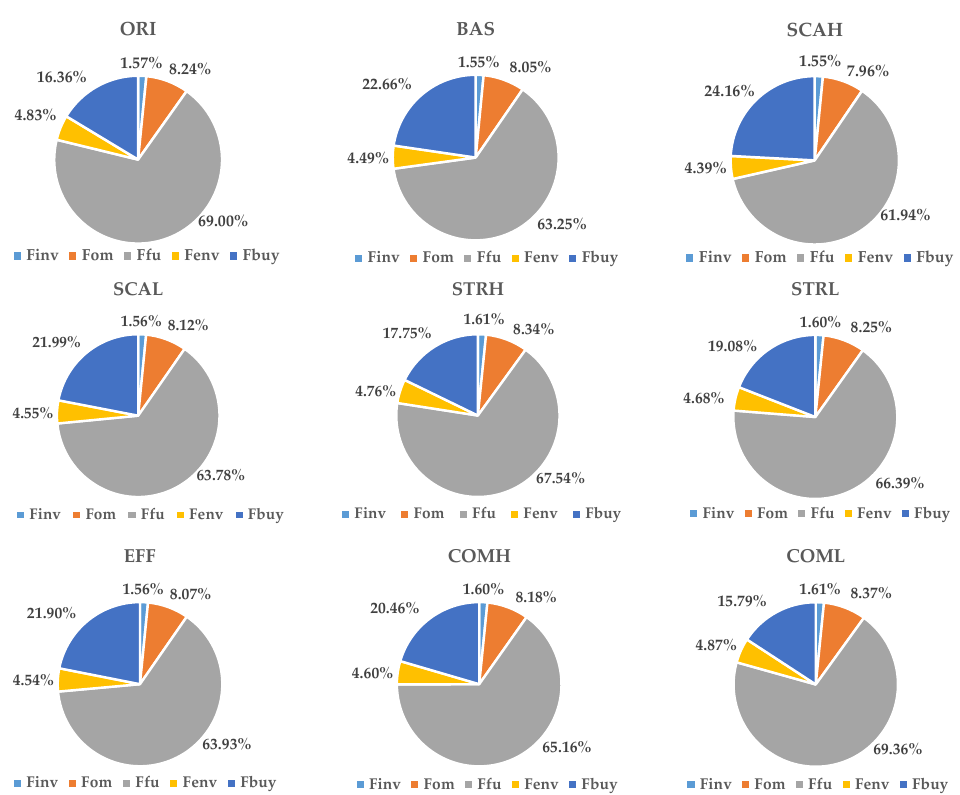
Figure 7. Proportions of various costs under different scenarios.